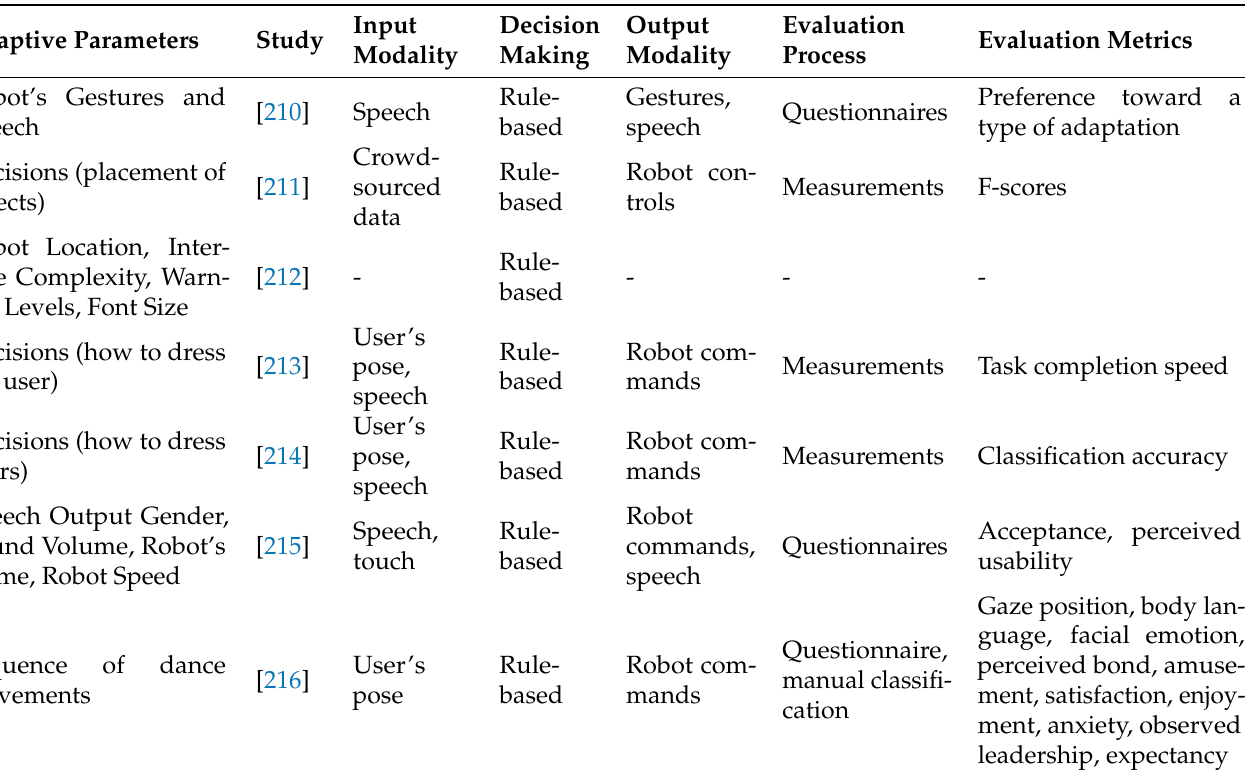
Table 8. Adaptive parameters, input modalities, framework of decision, output modalities and social robot evaluation with static user